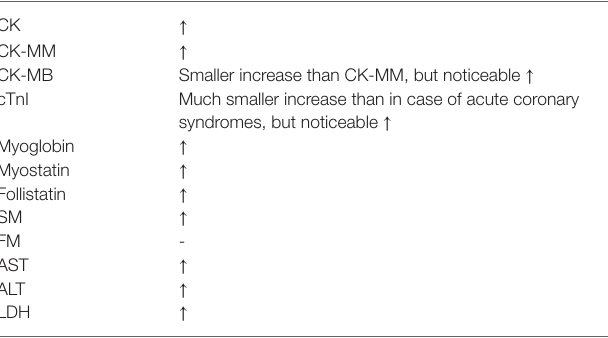
TABLE 1 | Muscle markers after participating in